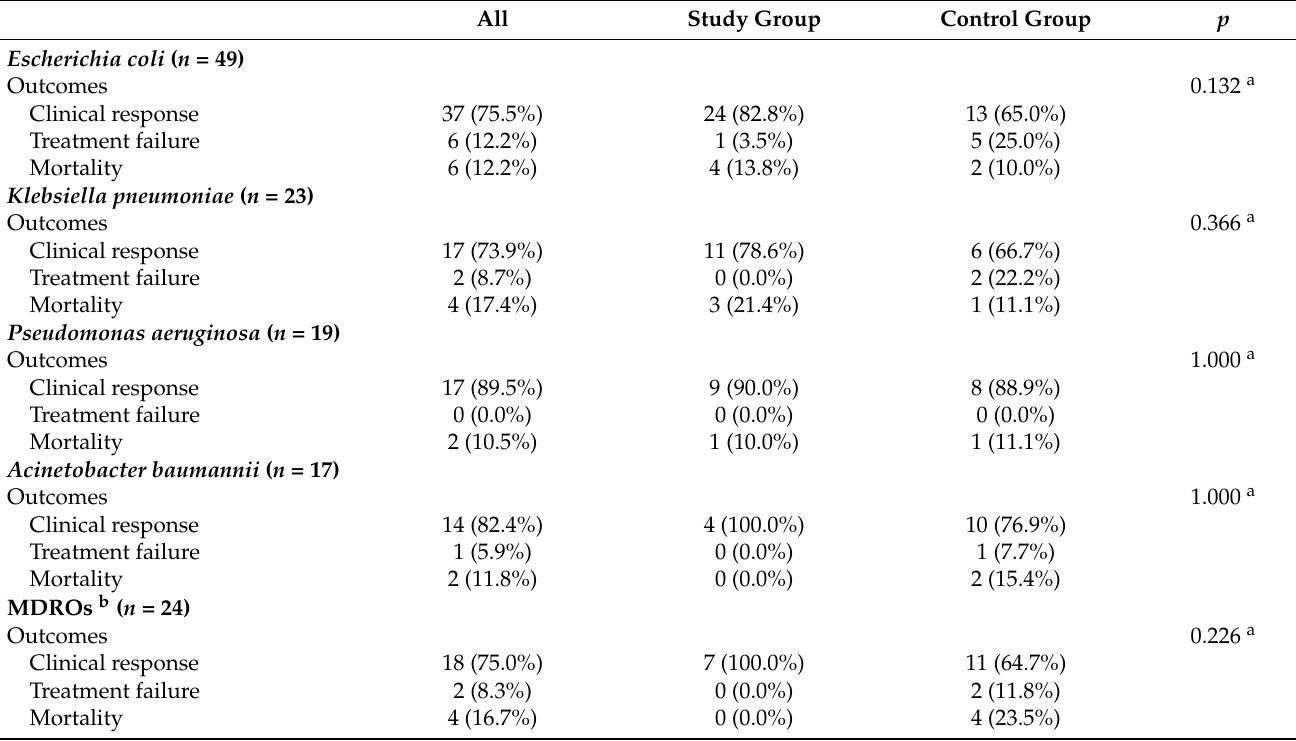
Table 4. Subgroup analysis according to specific